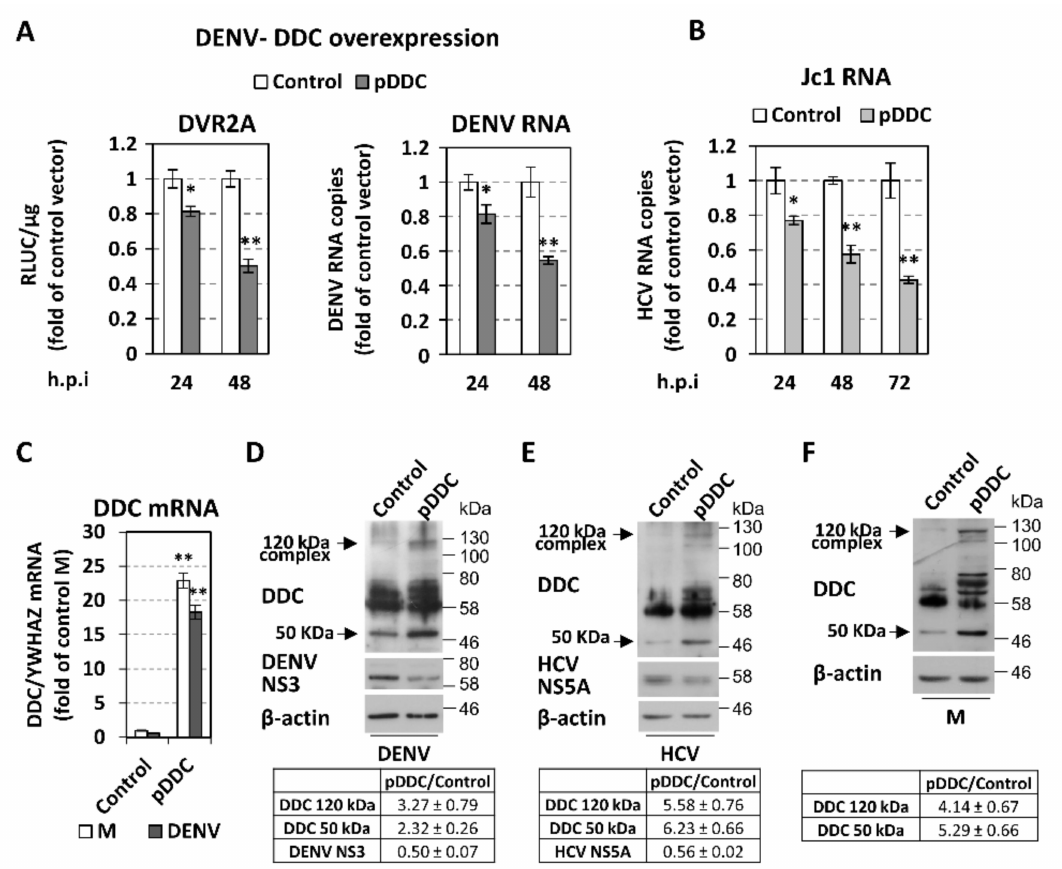
Figure 5. E ff ect of DDC overexpression on DENV replication. Huh7 or Huh7.5 cells were electroporated with pcDNA3.1( + )-DDC (pDDC) or the control vector, 24 h p.t were inoculated with DV-2 16,681 reporter (DVR2A, MOI = 0.1) or non-reporter (DENV, MOI = 1) virus or HCV Jc1 (MOI = 1) for 4 h, and were lysed at the indicated h p.i. ( A ) Left: DVR2A replication-derived Renilla luciferase (R-Luc) activity was quantified by chemiluminescence-based assay and expressed as relative light units (RLU) per µ g of total protein amount. Right: DENV positive-strand RNA levels were quantified by RT-qPCR and YWHAZ mRNA was used for normalization. ( B ) Jc1 positive-strand RNA levels were quantified by RT-qPCR and normalized. Bars represent mean values from three independent experiments in triplicate. Error bars indicate standard deviations. * p < 0.01 vs. control, ** p < 0.001 vs. control. ( C – F ) Total DDC mRNA and protein levels in cells electroporated with the pDDC plasmid or the control vector and then DENV-, HCV-, or mock-infected (M) for 48 h. ( C ) DDC mRNA levels were determined by RT-qPCR and normalized to YWHAZ mRNA. Bars represent mean values from three independent experiments in triplicate. Error bars indicate standard deviations. ** p < 0.001 vs. control vector-transfected cells. ( D – F ) (Top) Western blot analysis was performed in the electroporated cells infected with DENV ( D ), HCV ( E ), or mock-infected ( F ), using anti-DDC-CT, anti-DENV NS3, or anti-HCV NS5A and anti- β -actin antibodies. β -actin was used as loading control. A representative experiment of three independent repetitions is shown. (Bottom) Image quantification of DDC and DENV NS3 or HCV NS5A signals (mean values from three independent repetitions), normalized to β -actin and to the values obtained with control vector-transfected